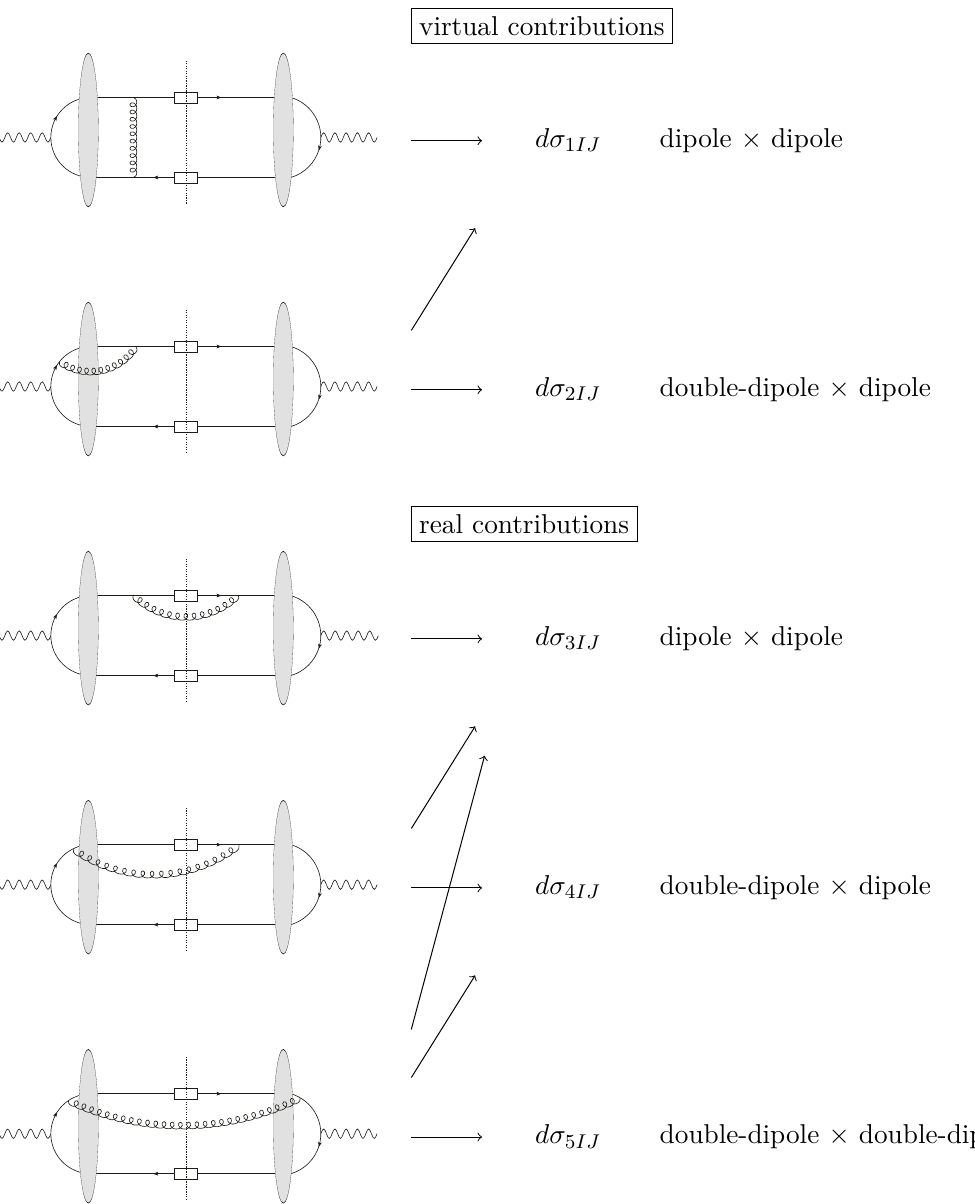
Figure 4 . Illustration of the 5 kinds of contributions to the NLO cross-section from the dipole point of view. Arrows show to which combination of dipole structures each type of diagrams